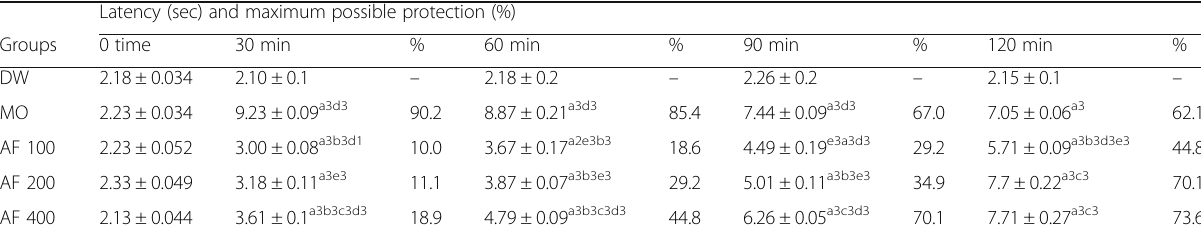
Table 2 Effect of aqueous fraction of Moringa stenopetala on radiant tail flick latency and maximum possible protection(%) Latency (sec) and maximum possible protection (%) Groups